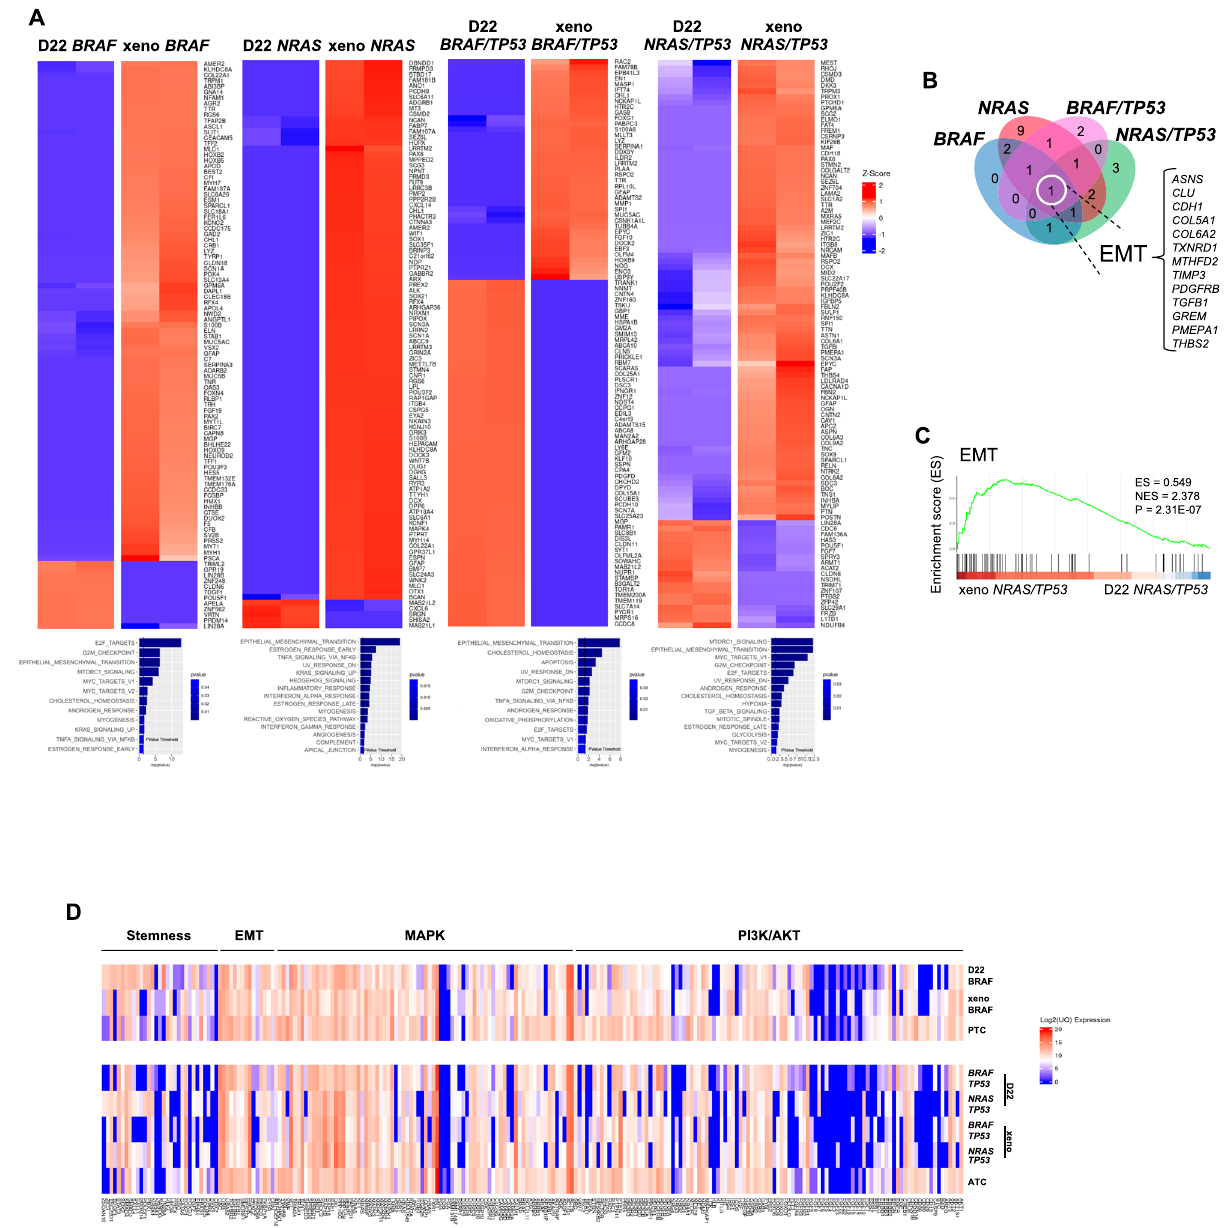
Fig. 4 | MAPK and PI3K/AKT pathways, along with EMT-associated signature, are enriched in D22 TPCs, mouse avatars and human PTC and ATC. A (upper panels) Heatmaps showing the top 100 differentially expressed genes (DEGs) with logFC > 2 obtained by total transcriptome analysis (mRNAseq), in engineered D22 TPCs harboring the pathogenetic TC mutations versus their derived-xenograft tumors. (lower panels) Barplots indicate the signi fi cantly enriched pathways ( p value < 0.05) performed using a Gene set enrichment analysis (GSEA) on Hall- mark category from MSigDB database of differentially expressed genes (DEGs) obtained by RNAseq. B Venn diagram of the common enriched pathways in